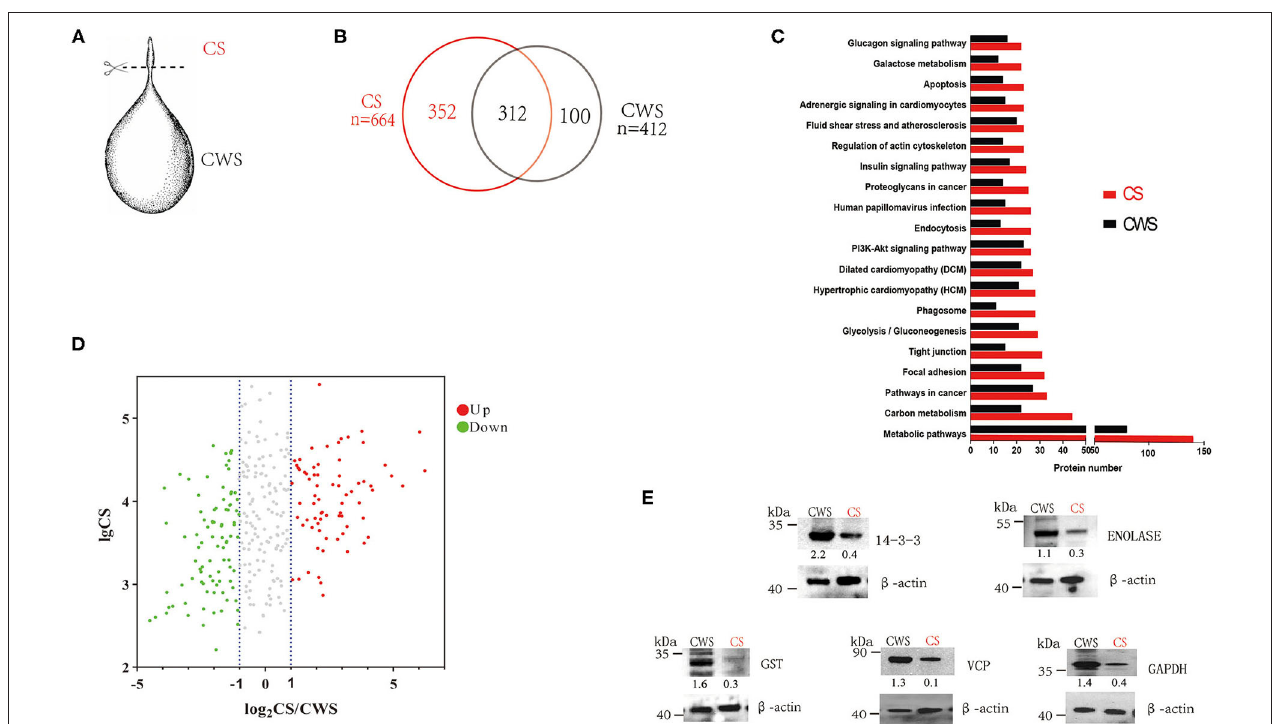
FIGURE 1 | Comparative proteomes of the scolex and the rest part of T. hydatigena cyst. (A) Individual T. hydatigena cysts were scissored into two parts, the scolex, designated as CS, and the rest (the cyst without scolex), designated as CWS. (B) Protein identification in different two parts. ( C ) Top 20 pathways in CS and CWS proteins. (D) 312 proteins commonly shared by CS and CWS. Up- and down-expressed protein in the CS were identified with an abundance fold change (CS/CWS) of 2 and 0.5, respectively. To clearly show which proteins are abundant and differentially expressed, a volcano plot was pictured by use of CS abundance and abundance fold changes. (E) Validation of 5 proteins by Western blotting. Numbers represent relative abundance of a given protein in CS or CWS. Beta actin is used as a reference and its abundance is set as